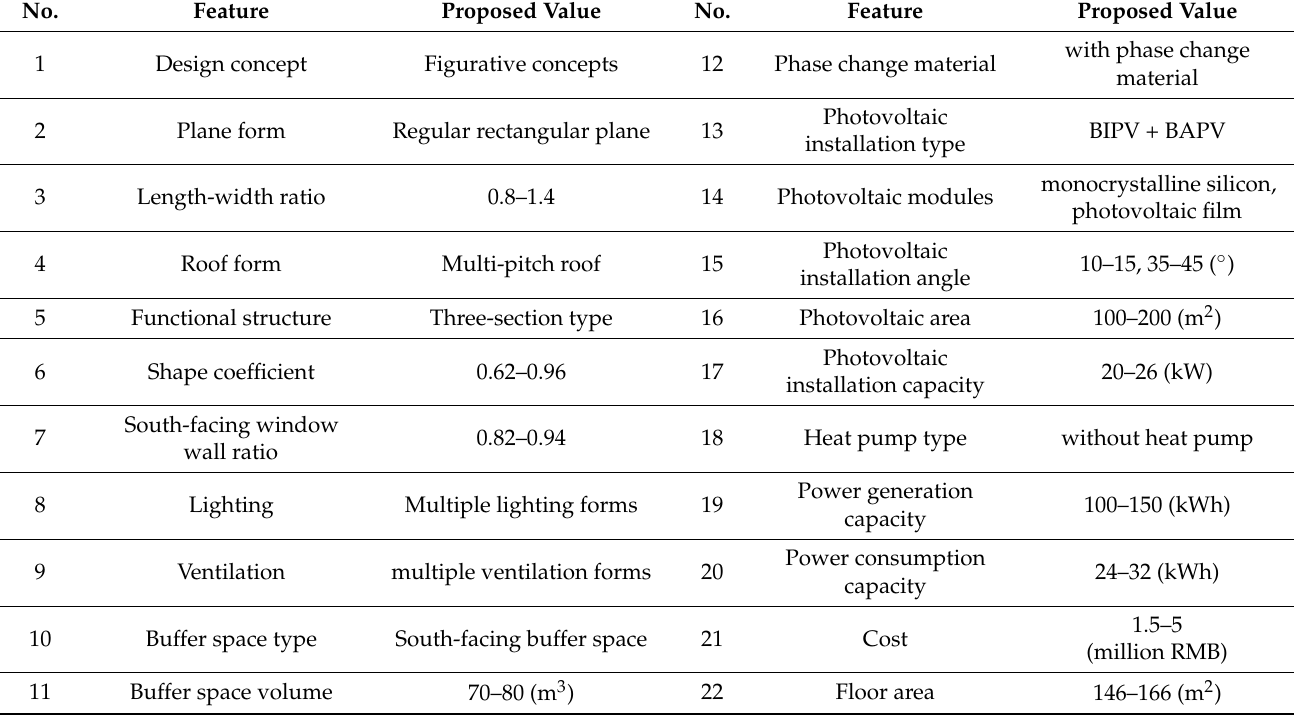
Table 14. Empirical model of energy-saving design strategies for zero-energy houses in Zhangbei